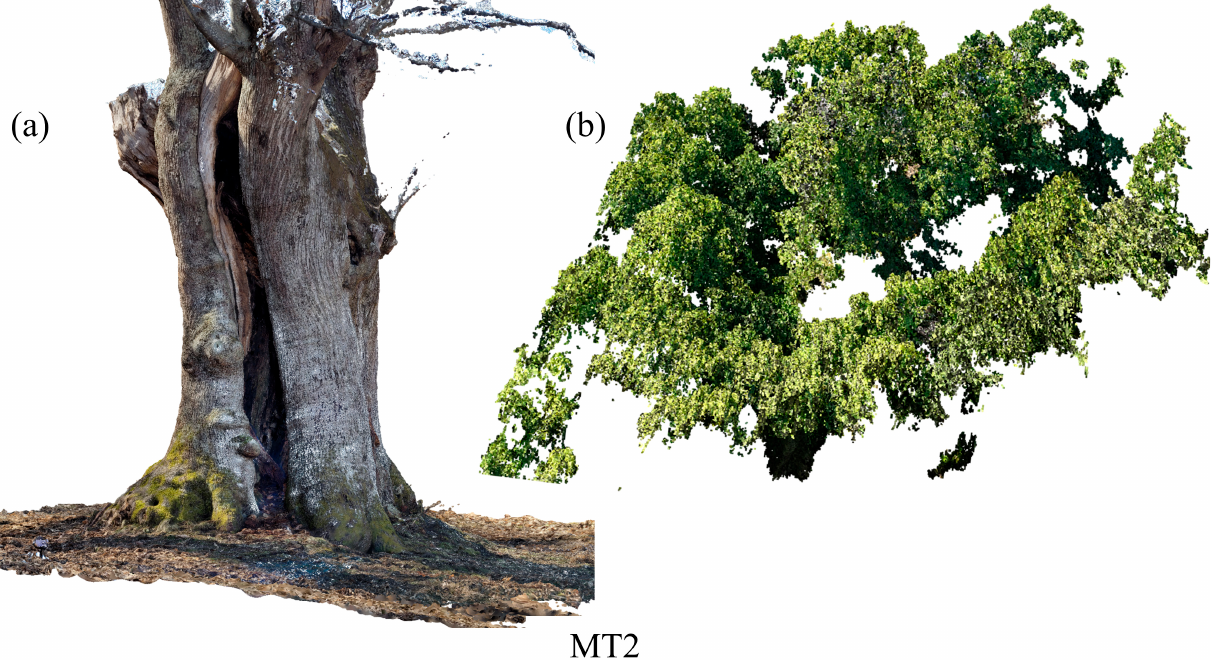
Figure 4. Detailed view of the MT2 dense clouds obtained through the AMP software. ( a ) SLR dense cloud representing the monumental trunk with pronounced buttresses and visible defects and ( b ) the UAV dense cloud representing the canopy top which was not detectable with the MLS in the summer survey.